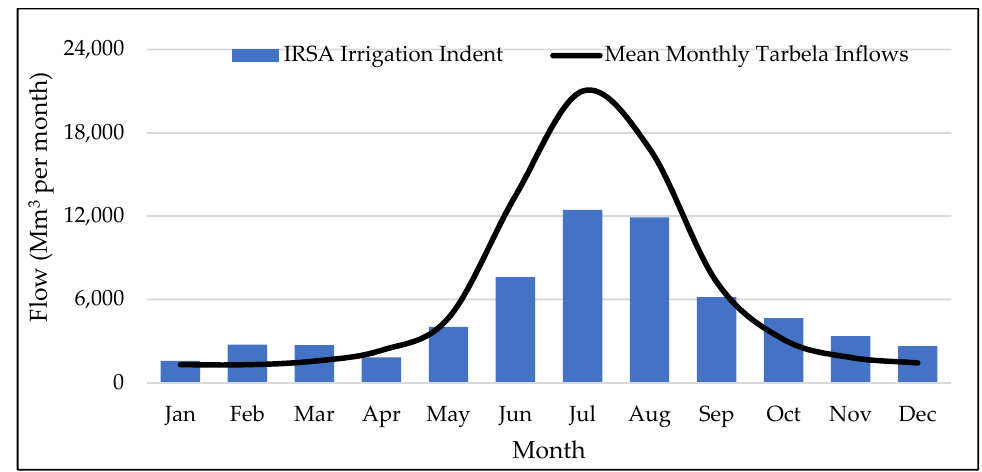
Figure 1. IRSA Irrigation Demand Pattern on d/s of Tarbela Reservoir [9]. Table 1. Monthly energy demand profile of Tarbela Reservoir [9].